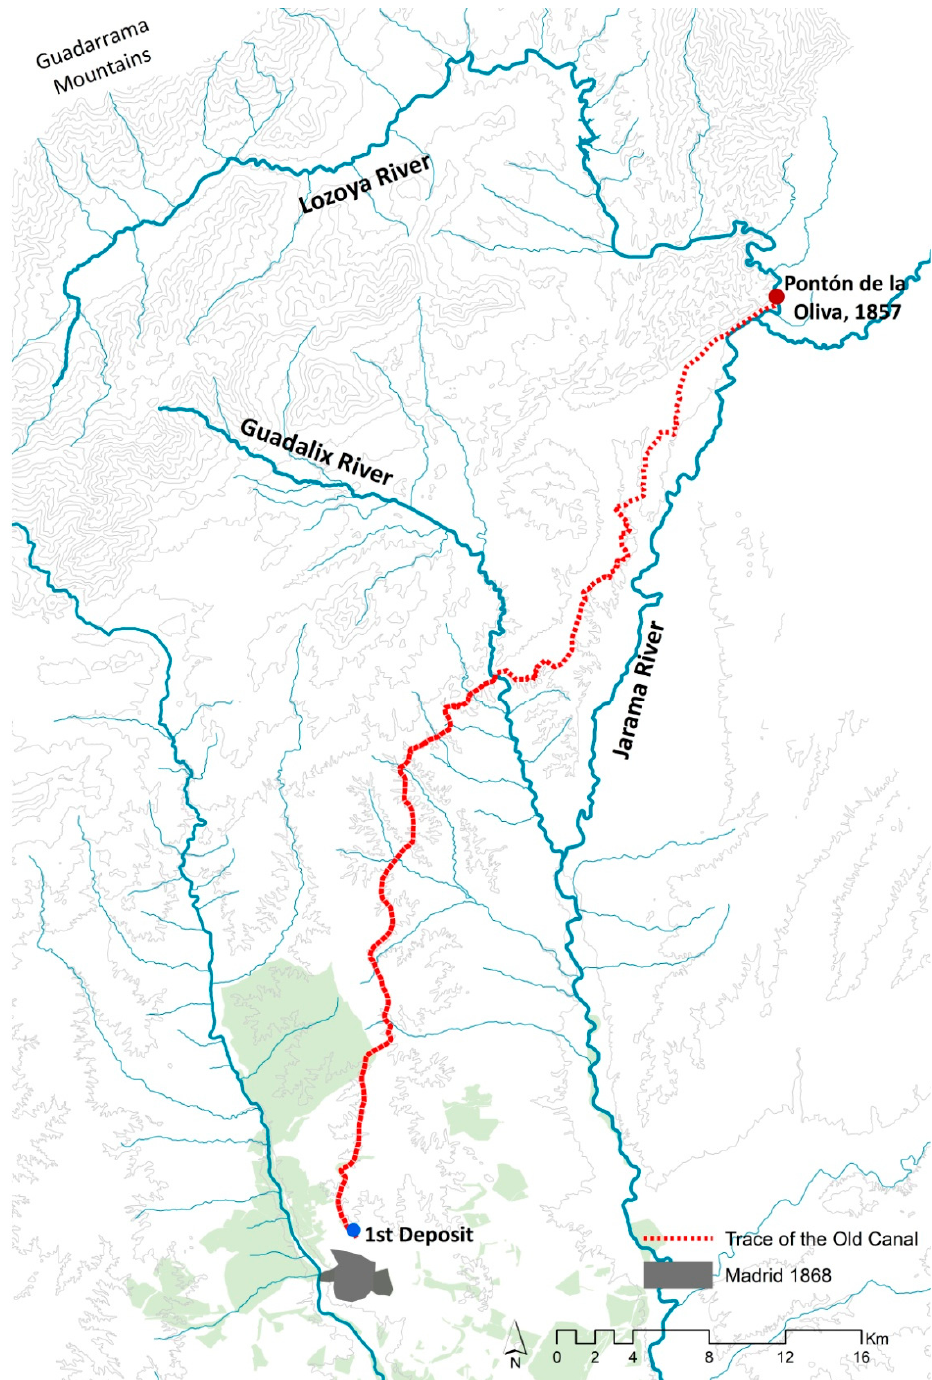
Figure 3. Ground route of the first Canal de Isabel II, 1868. Source: Created by the authors.